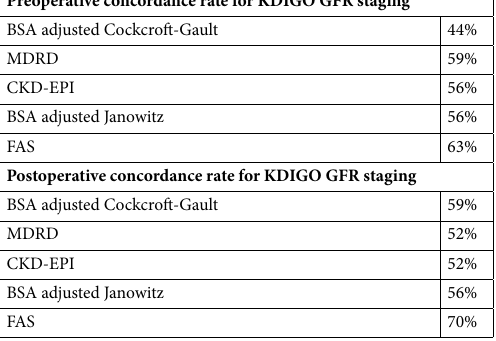
Table 5. Concordance rate for KDIGO GFR staging between measured GFR and estimated GFR. BSA body surface